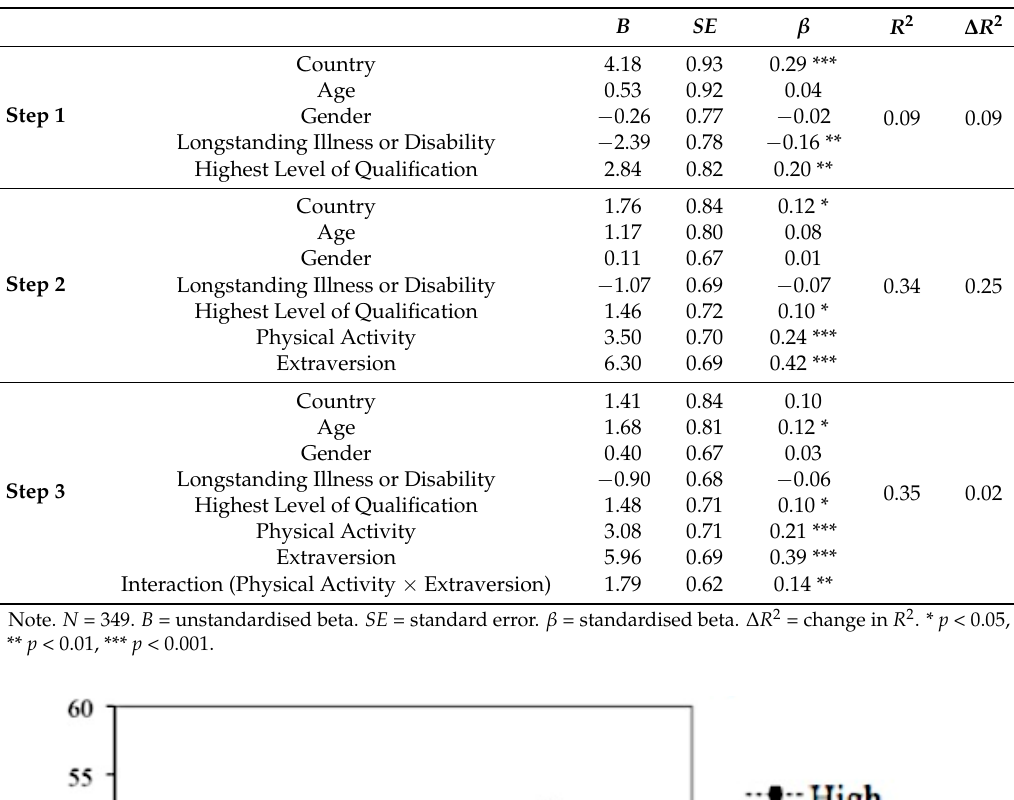
Table 4. Interaction analysis for physical activity and extraversion.